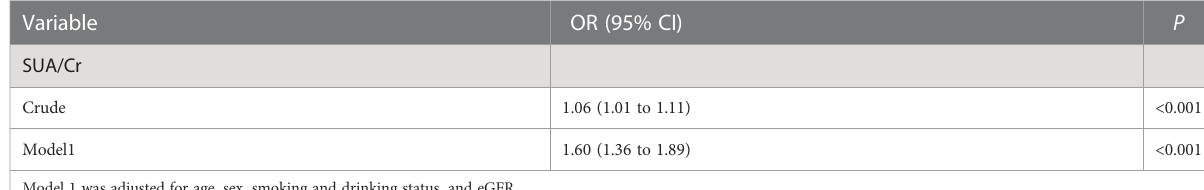
TABLE 2 The associations between SUACr and the prevalence of MetS. Variable